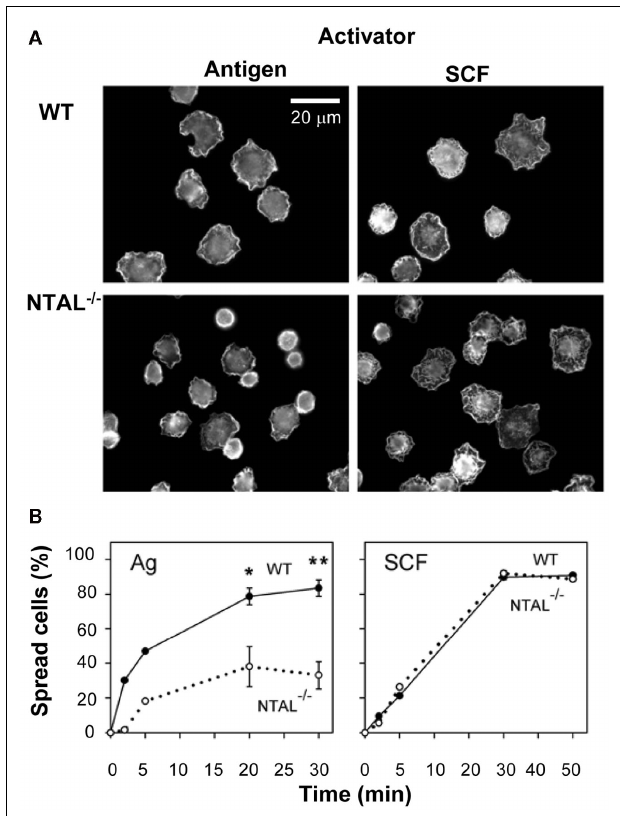
FIGURE 4 | Non-T cell activation linker positively regulates spreading on fibronectin in BMMCs activated via Fc ε RI but not via SCF. (A) IgE-sensitizedWT cells or NTAL − / − cells were activated for 20min with antigen or SCF, fixed and stained for F-actin with phalloidin-Alexa Fluor 488 conjugate.The images are confocal micrographs taken at equatorial planes. Scale bar, 20 μ m. (B) WT cells (full line) or NTAL − / − cells (dotted line) were activated with antigen or SCF for the indicated time intervals, fixed and stained for F-actin as in (A) . Proportion of spread cells was calculated from > 200 cells evaluated at each time interval. Means and SE were calculated from two (5min) or five (20 and 30min) independent experiments. Significance of differences at given times betweenWT and NTAL − / − cells is also shown (* p < 0.05; ** p < 0.005; Student’s t -test). Originally published in European Journal of Immunology (Tumová et al., 2010) where all experimental procedure details have been